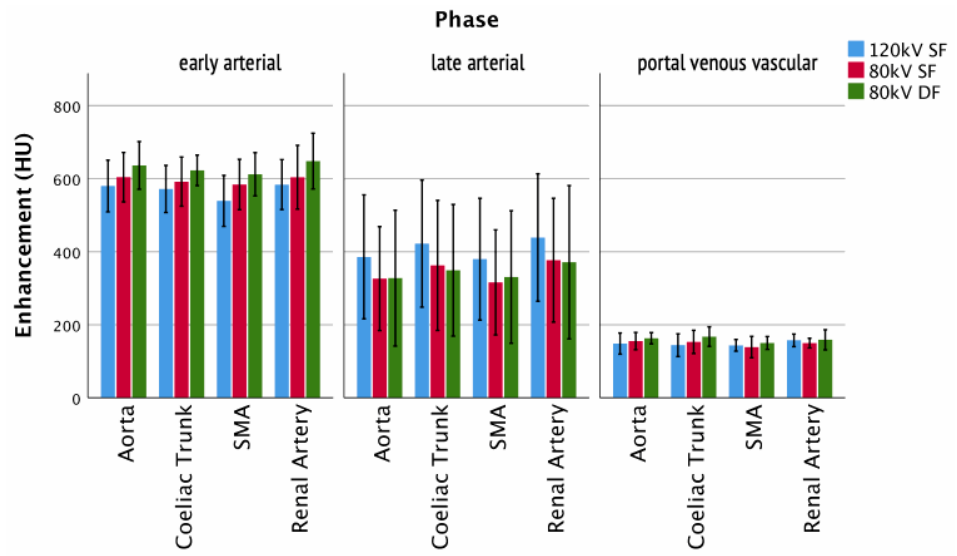
Figure 6. Enhancement of renal structures. Columns show the enhancement of clinically relevant structures of the kidney for the different injection protocols and clinically relevant phases.